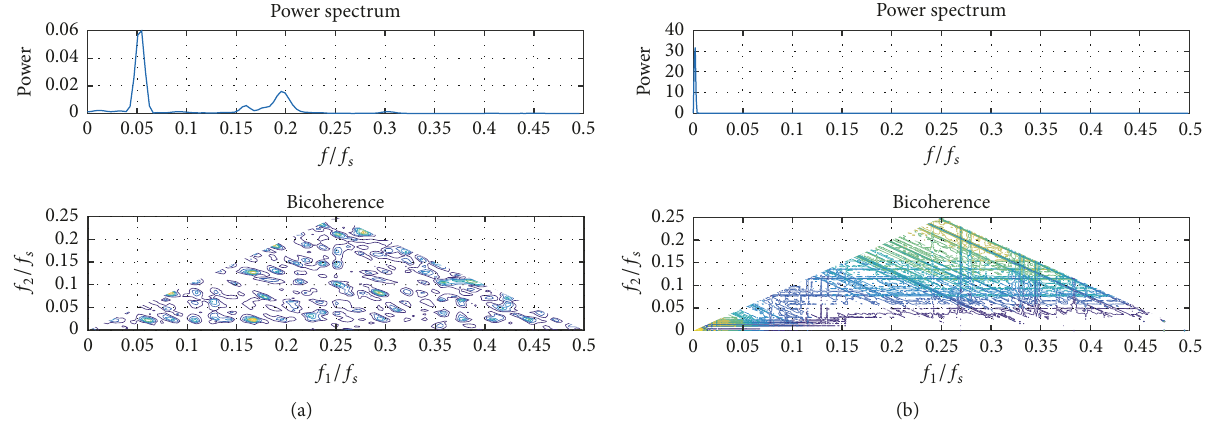
Figure 9: (a) Bicoherence of state 𝑥 . (b) Bicoherence of all states of FOPF